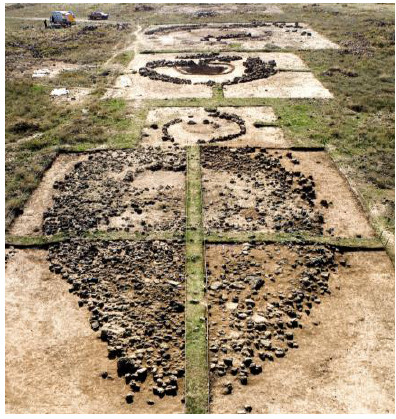
Figure 4. Archaeological fields of Nerqin Naver